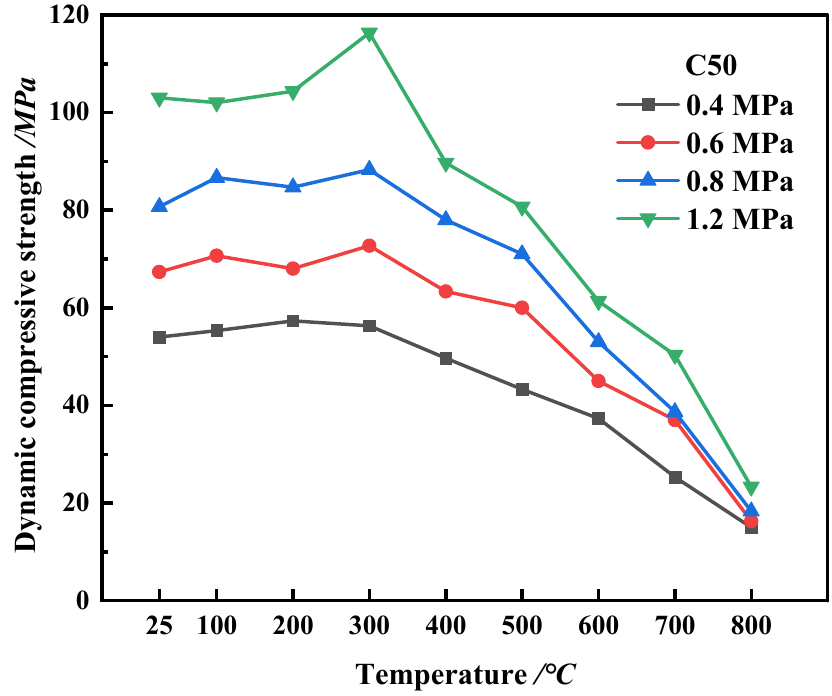
Figure 13. Dynamic compressive strength curves of concrete with grade C50.